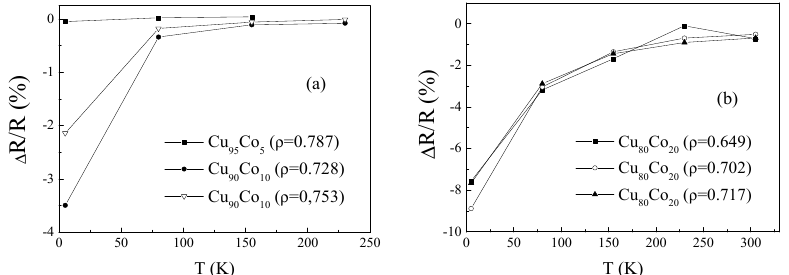
Figure 19. ∆ R / R (T) determined from the ∆ R / R (H) with maximum field of 50 kOe for Co 5 Cu 95 and Co 10 Cu 90 ( a ) and Co 20 Cu 80 ( b ). Reproduced from reference [83], Figures 2 and 3. After annealing we observed gradual increasing of ∆ R/R (see in Figure 20a a comparison of ∆ R/R( H ) for as-prepared and annealed at 400 °C for t ann = 1 h and 5 h Co 10 Cu 90 microwires). After long enough annealing we observed increasing of ∆ R/R up to 32% (see Figure 20b). Similar behavior has been observed for Cu 95 Co 5 and Cu 80 Co 20 microwires (Figure 21) [83,84]. The highest value of ∆ R/R ≈ 32% is observed for Cu 90 Co 10 microwires.